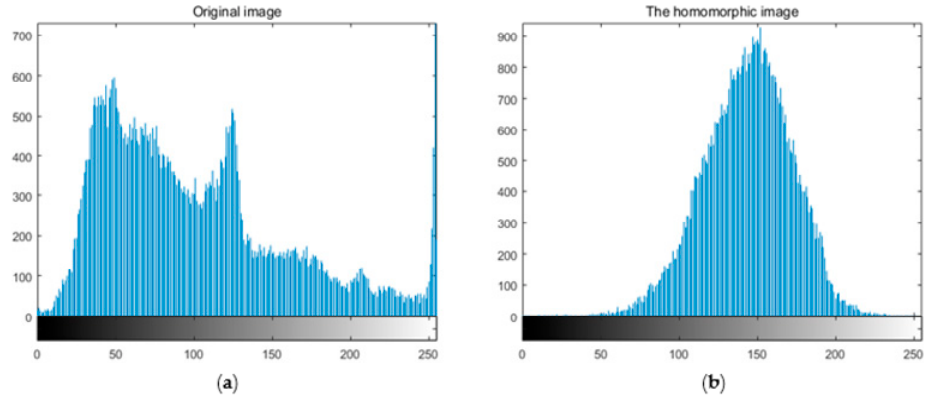
Figure 10. ( a ) Histogram of the original image; ( b ) histogram after the homomorphic filtering.